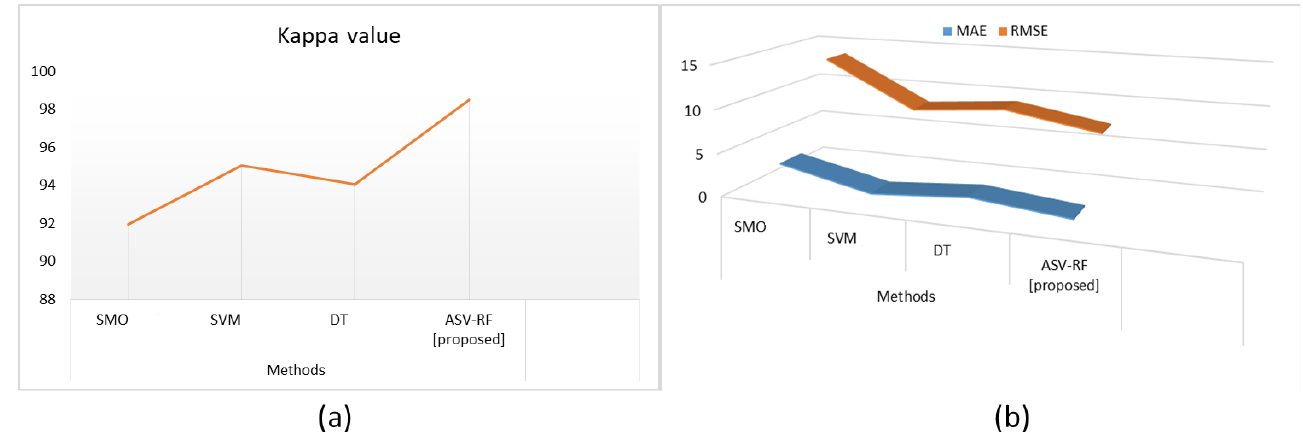
Figure 5. Results of f1-score, recall, sensitivity, and specificity metrics.